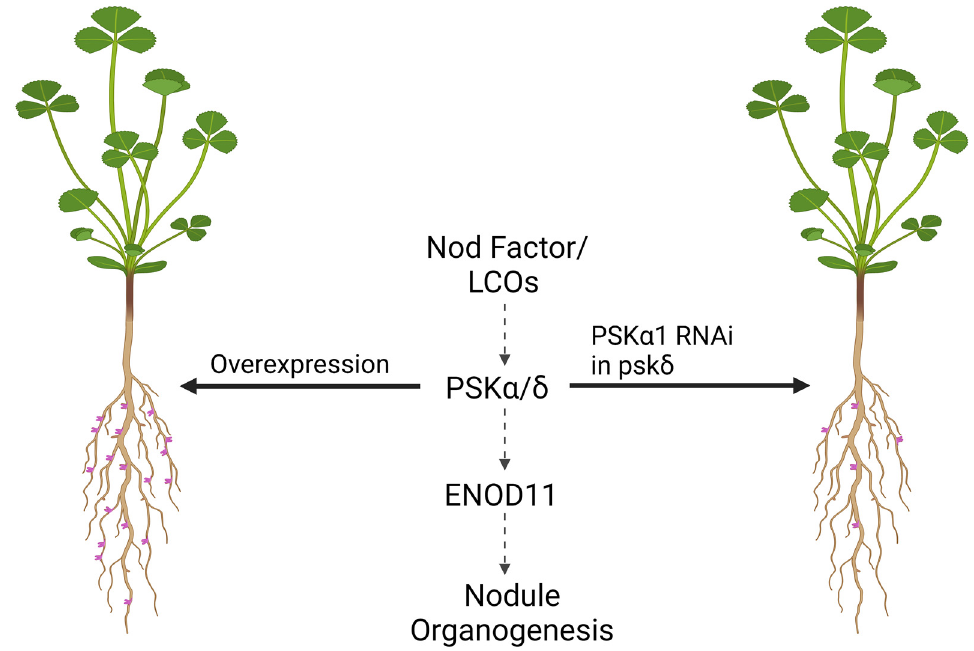
Figure 1. A schematic representation showing the role of PSKs in nodule organogenesis. PSK α and PSK δ are activated downstream of Nod-factors or LCOs perception and activate ENOD11 expression. The overexpression of PSK α / δ results in increased nodulation (left). PSK α / δ act redundantly towards each other, with decreased nodulation phenotype observed only in RNAi lines of PSK α in psk δ mutants ( Tnt1 lines) (right). Dashed arrows indicate the proposed activation of genes in the common symbiotic pathway. The figure compares only the nodule numbers. Figure created using Biorender.